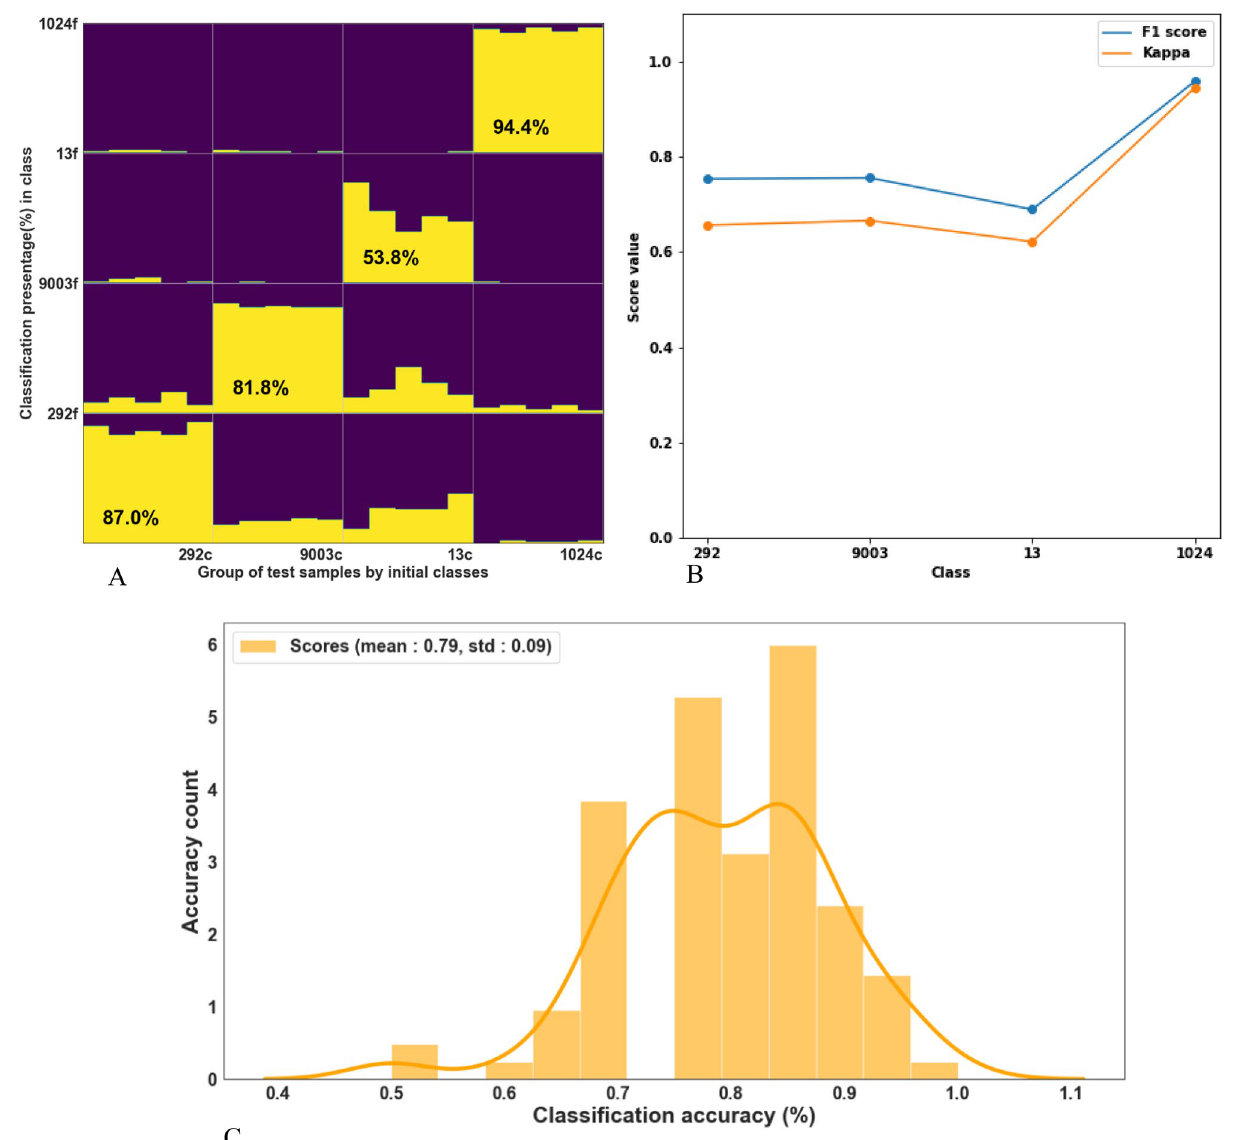
Figure 4. Classification of charred pips using fresh pips as a train set. ( A ) Accumulative distribution of LDA classification after running 100 tests. At each run, 10 random pips from the assemblage were selected as the constant training group, and the 5 remaining burned random pips were classified independently; ( B ) F1 and Kappa scores of random fresh vs charred data splits with 100 iterations, ( C ) Classification accuracy histogram—100 training [10 fresh samples] and independently 100 tests (5 remaining